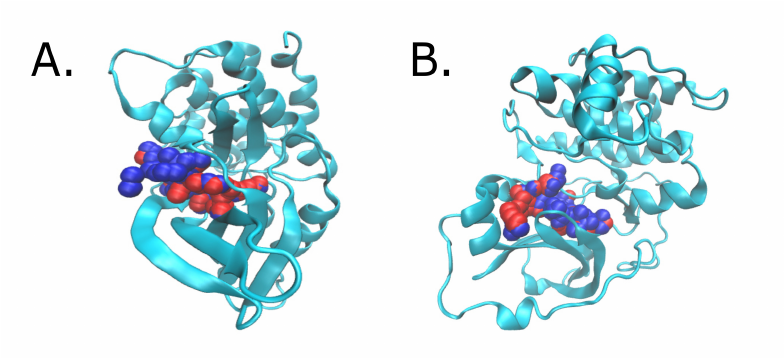
Figure 1. Protein structure visualization with VMD software for CDK ( A ) and AKT ( B ) homologues in L. braziliensis . The most druggable pocket is shown. Polar alpha spheres are depicted in red, while apolar alpha spheres are in blue.